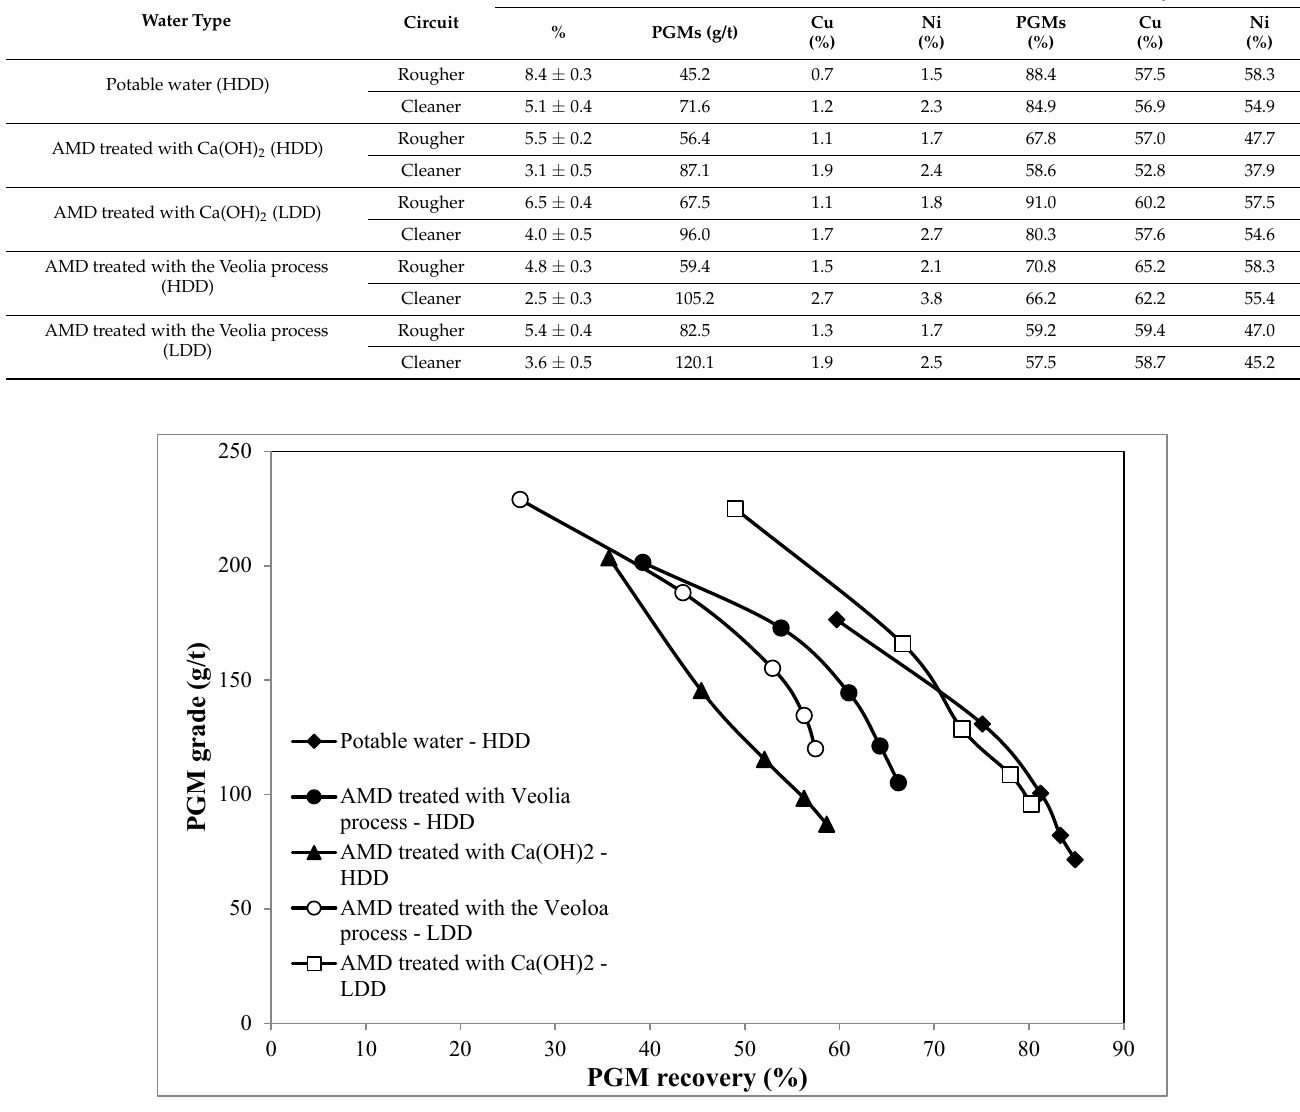
Figure 3. Effect of reducing depressant dosage on the flotation response of the Merensky ore. LDD = 25 g/t; HDD = 50